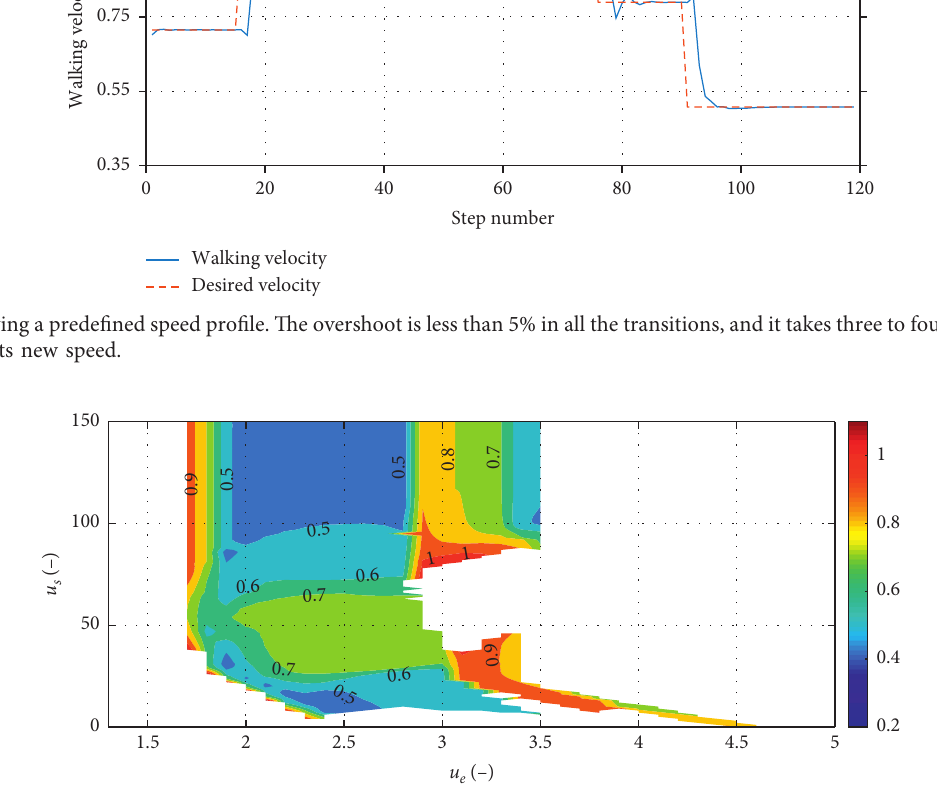
Figure 9: The local stability represented by the maximum eigenvalue of the Jacobian